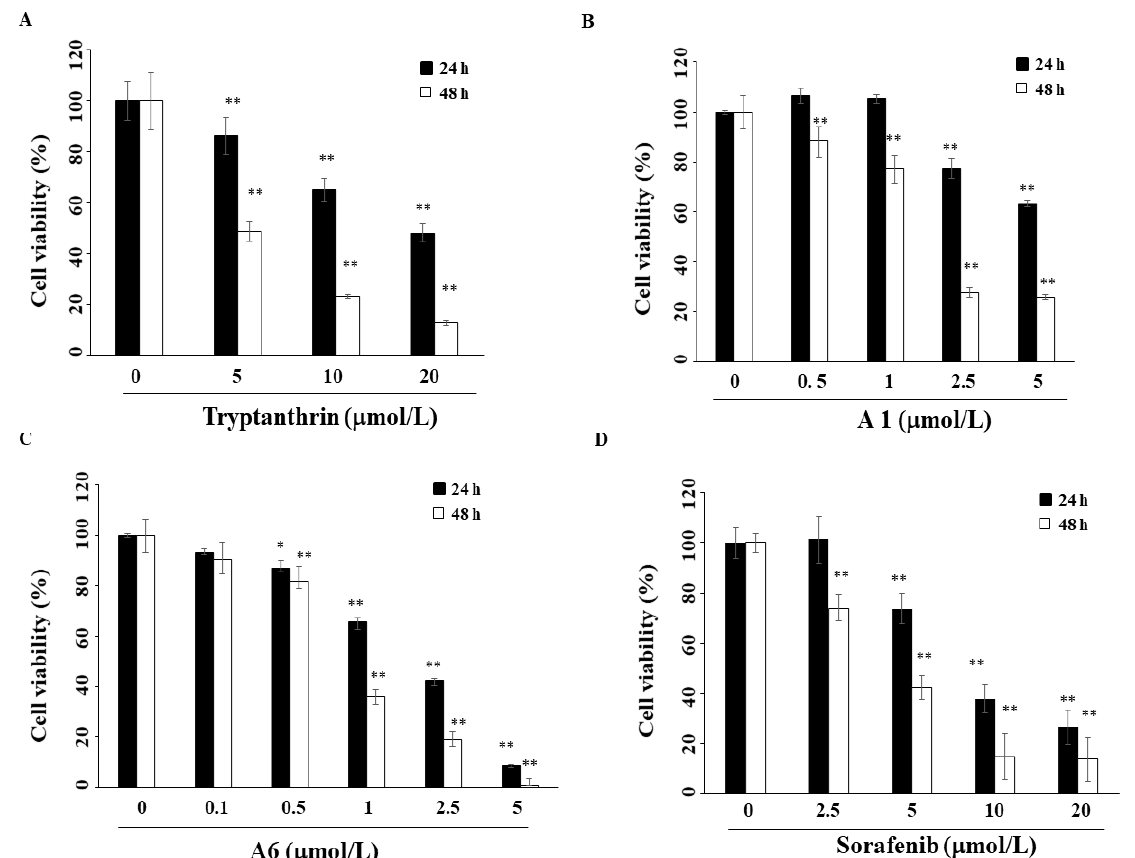
Figure 2. ( A ) Anti-proliferative effects of tryptanthrin, ( B ) A1, ( C ) A6, and ( D ) sorafenib in Hep3B cells. Cells were treated with the above compounds for 24 h or 48 h, and cell viability was detected via MTT assay. Points , means; bars , S.D. ( n = 3). * P < 0.05, ** P < 0.01.